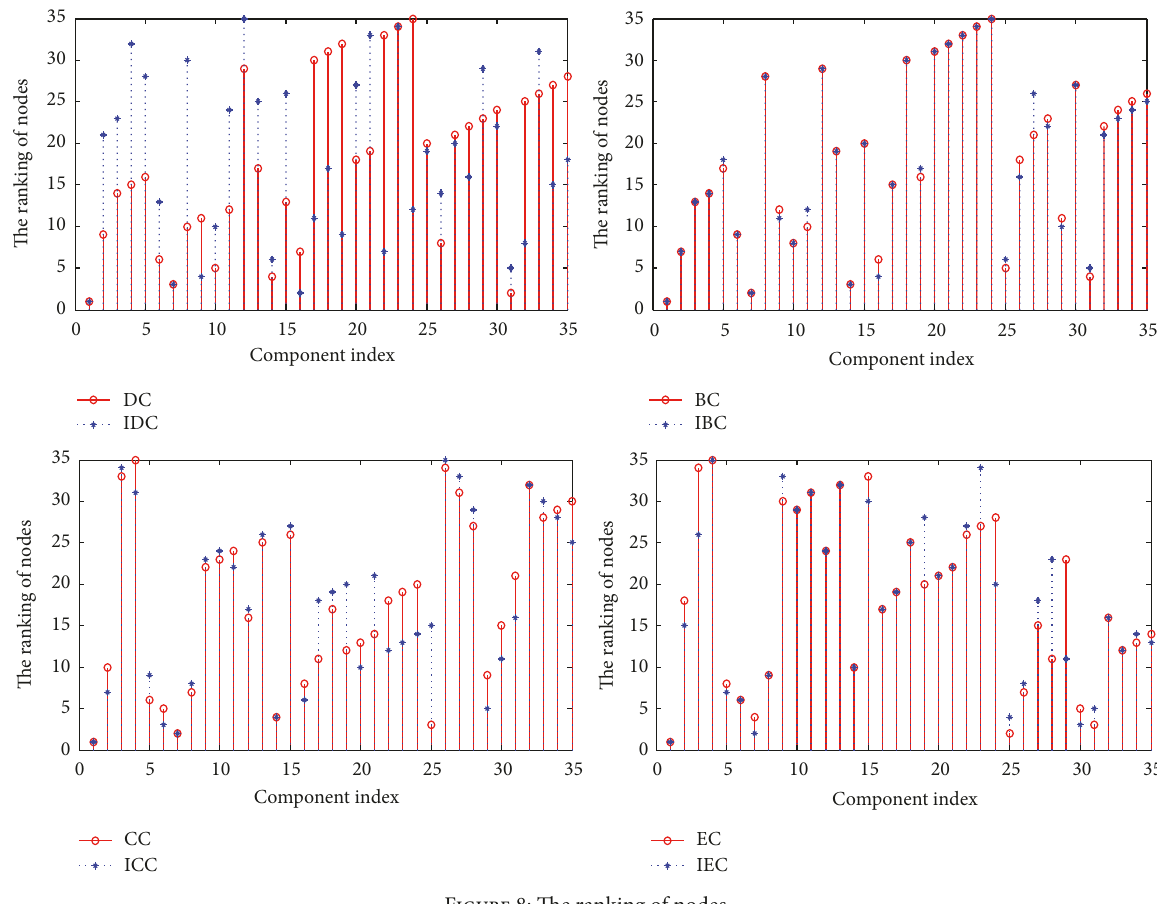
Figure 8: The ranking of nodes.